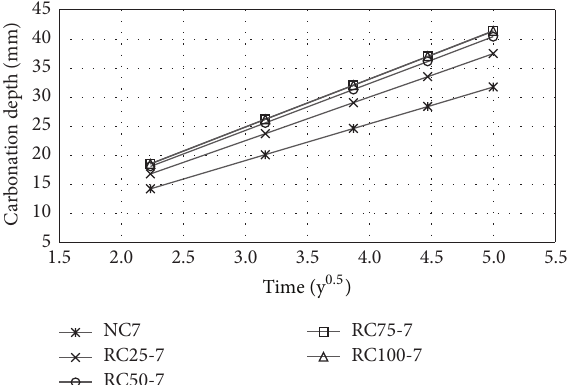
Figure 6: Calculated progress of carbonation depth versus time for 0.7